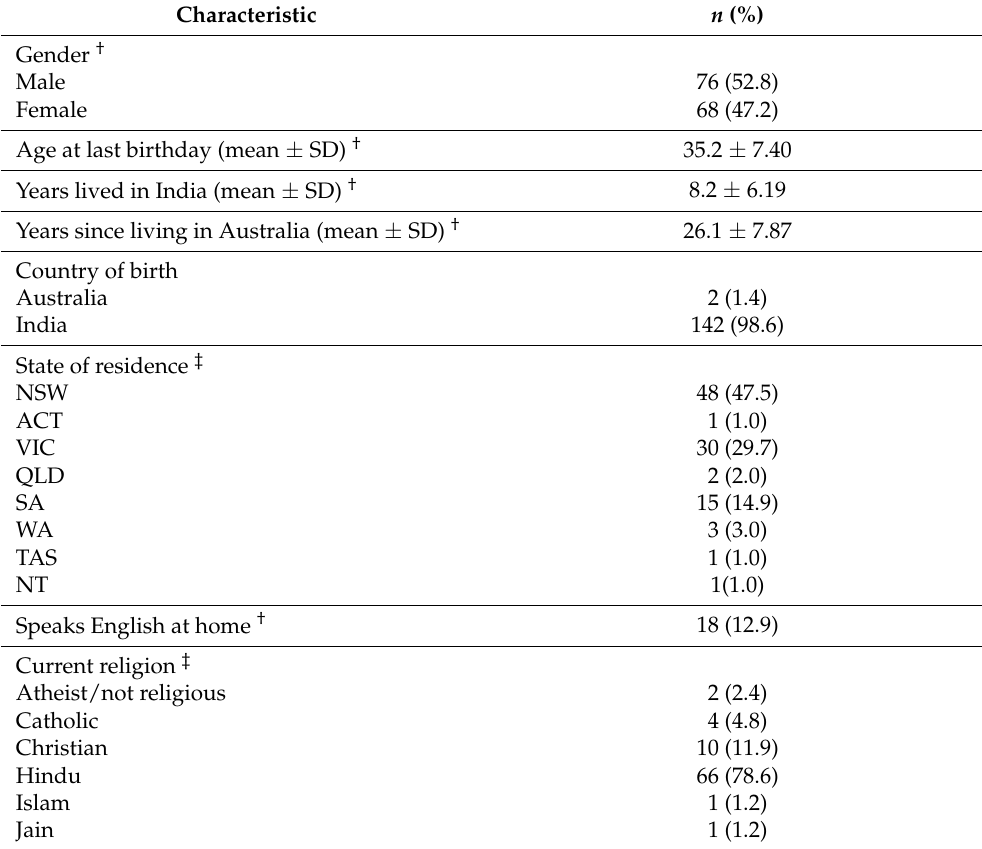
Table 2. Demographics characteristics of included